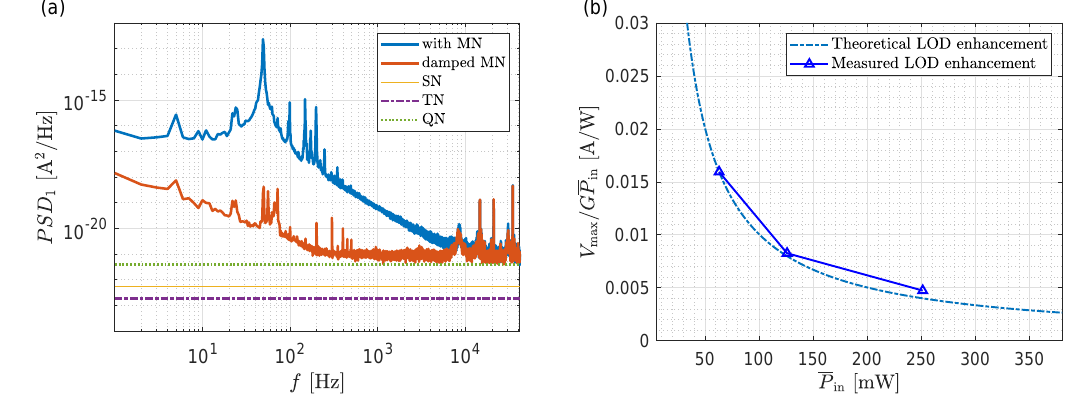
Figure 5. ( a ) Shows the theoretical shot (fine orange), electrical (purple dashed), quantization (green dashed) current power spectral densities, and the measured power spectral densities with mechanical noise and with dampened mechanical noise. ( b ) In the presence of dominant quantization noise the LOD is expected to follow the ratio V max / ( GP in ) , which is in good agreement with the experimental